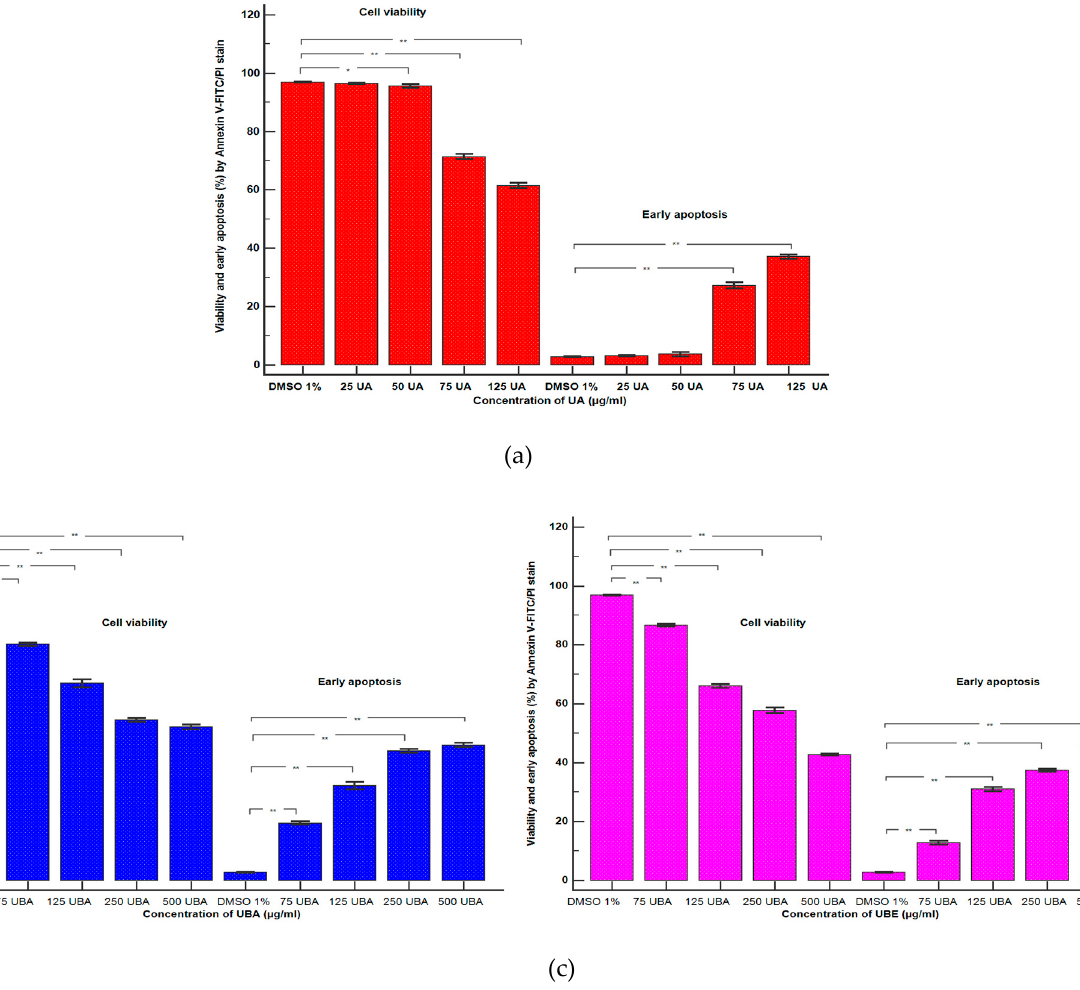
Figure 3. Statistical analysis of cell apoptosis: ( a ) UA; ( b ) UBA; ( c ) UBE. * p < 0.05 and ** p ≤ 0.001 represent significant statistical differences between control and samples made by paired samples t -test.